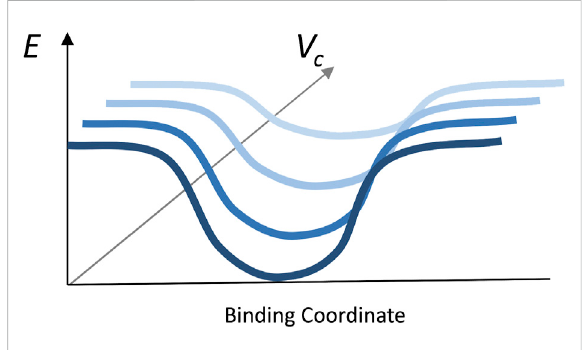
FIGURE 6 Illustration of the principle of the funnel size reduction with the increase of crowder volume fraction.